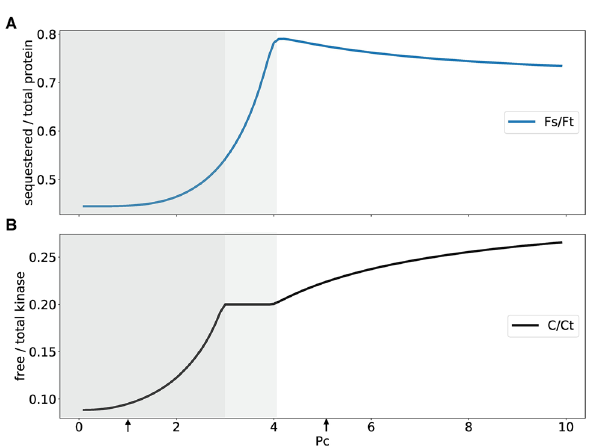
Figure 4. Simulating nonlinear phosphorylations at higher enzyme levels: (A,B) show time-courses of phosphorylated F proteins. Graph (C) shows the concentrations of FC complexes over time. (D) shows the temporal switch of free kinase C after release from sequestration. The dynamics of total kinase Ct, not shown here, is similar as in Fig 3.